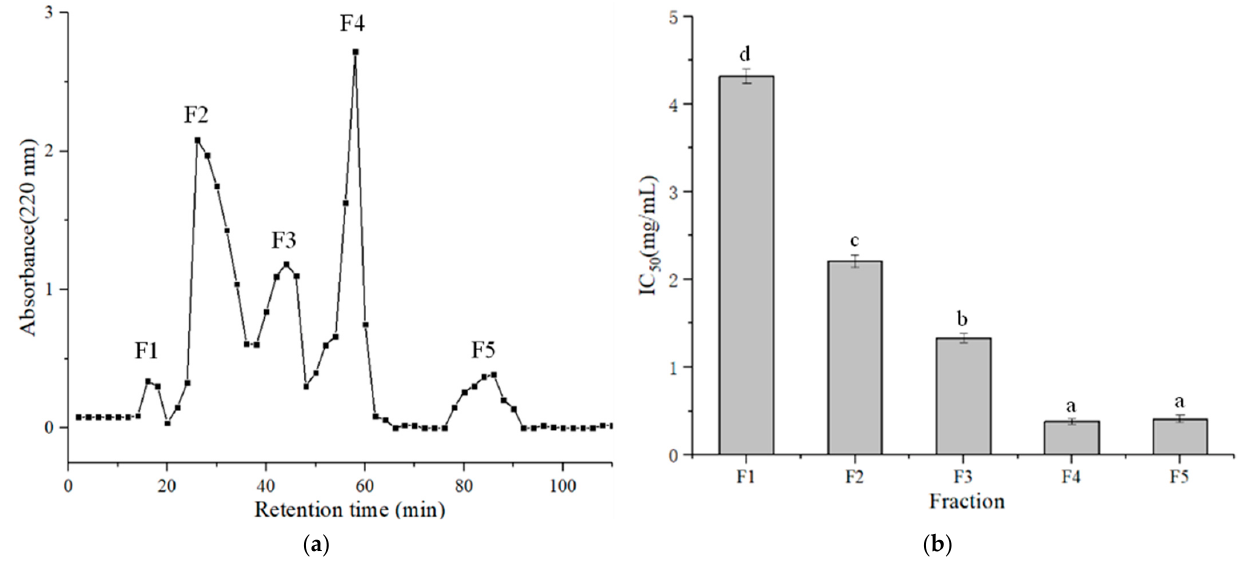
Figure 2. Gel filtration chromatography of LMPH I on a Sephadex G-15 column ( a ), and ACE- inhibitory activities of fractions F1–F5 ( b ). The column values of a–d with the different superscript indicated a significant difference ( p < 0.05).